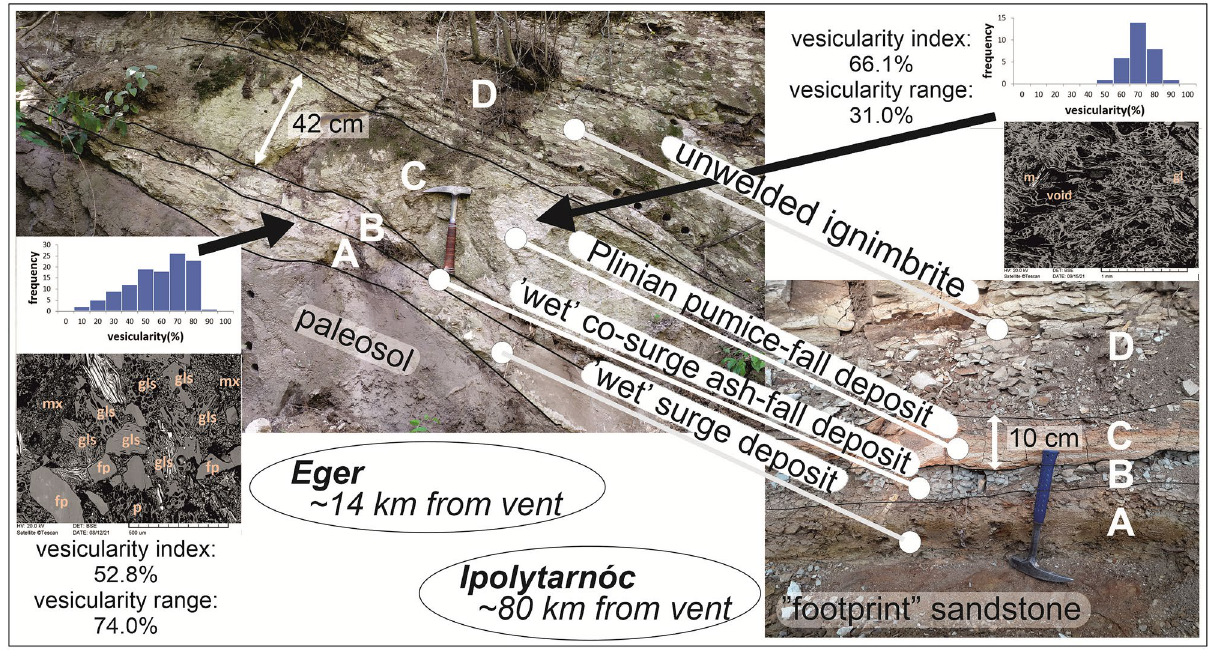
Figure 2. Correlation of two identical volcanic successions of the multi-phase Eger-Ipolytarnóc eruption showing macro- and microscopic features. On the left, the medial Eger Homok Street, on the right, the more distal Ipolytarnóc Fossil Site; both showing the correlated pyroclastic units ( A - D ). Insets display BSE images and vesicularity statistics (Supplement 1) for the first-phase (Unit A), low-temperature phreatomagmatic surge (bottom left), and the third-phase (Unit C) Plinian pumice fall (upper right). Photo credit: Dávid Karátson. Abbreviations in BSE images: mx—fine-grained matrix, fp—feldspar, gls—glass shard, m—mica, gl—glass, p— pumice. BSE (Backscattered Electron) images of selected thin sections were recorded using an AMRAY 1830 I/ T6 Scanning Electron Microscope (Eötvös